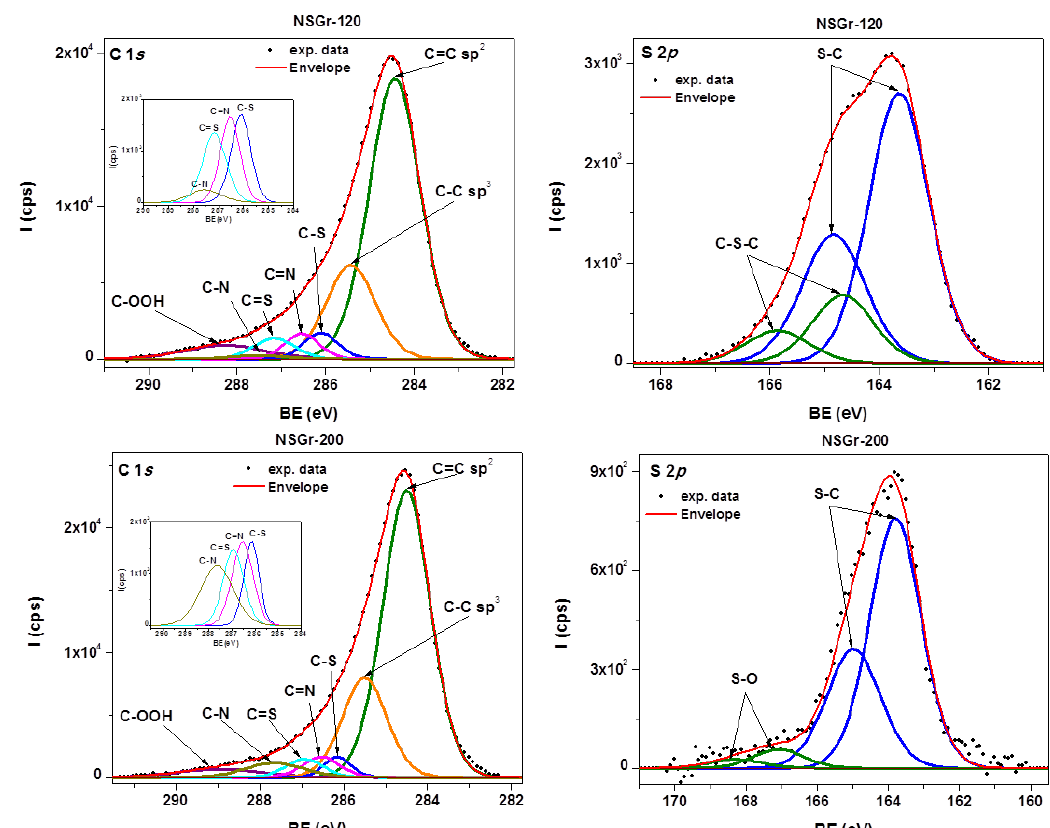
Figure 3. High-resolution XPS spectra of C1s and S2p with the corresponding deconvolution components for the investi- gated samples.